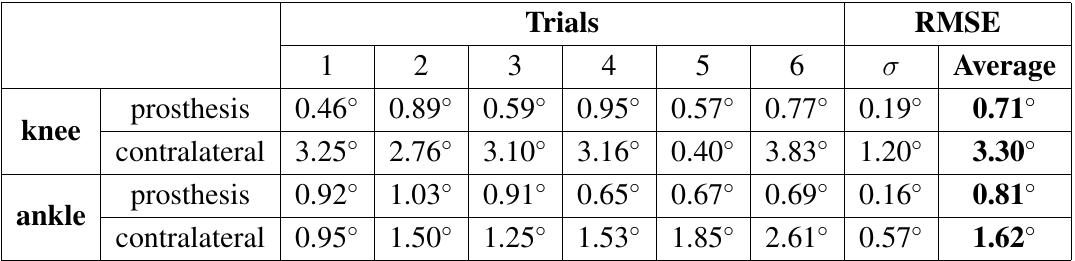
Table 1. Deviations between the knee flexion/extension and ankle plantar/dorsiflexion angle measurements of the optical and the inertial system for six gait trials of a transfemoral amputee. Results are given for α only, since both methods yield very similar results. acc+gyr The deviations vary little ( σ ≈ 1 ◦ ). For the knee angles, the same difference in the accuracies of the prosthesis and human leg is observed as in Figure